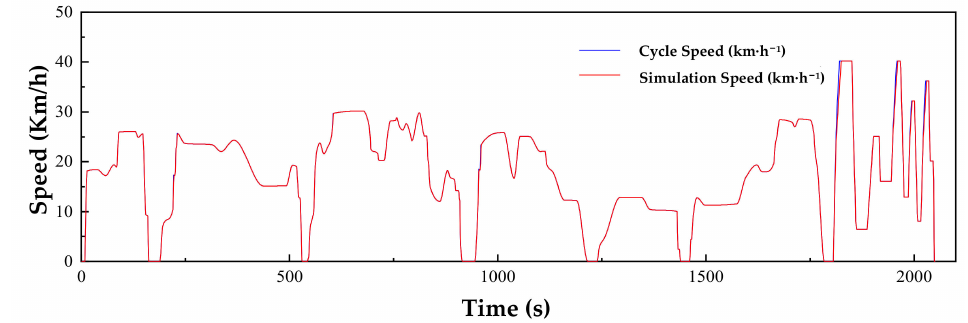
Figure 22. Curves of speed with time under the CYC_WCQ driving cycle.